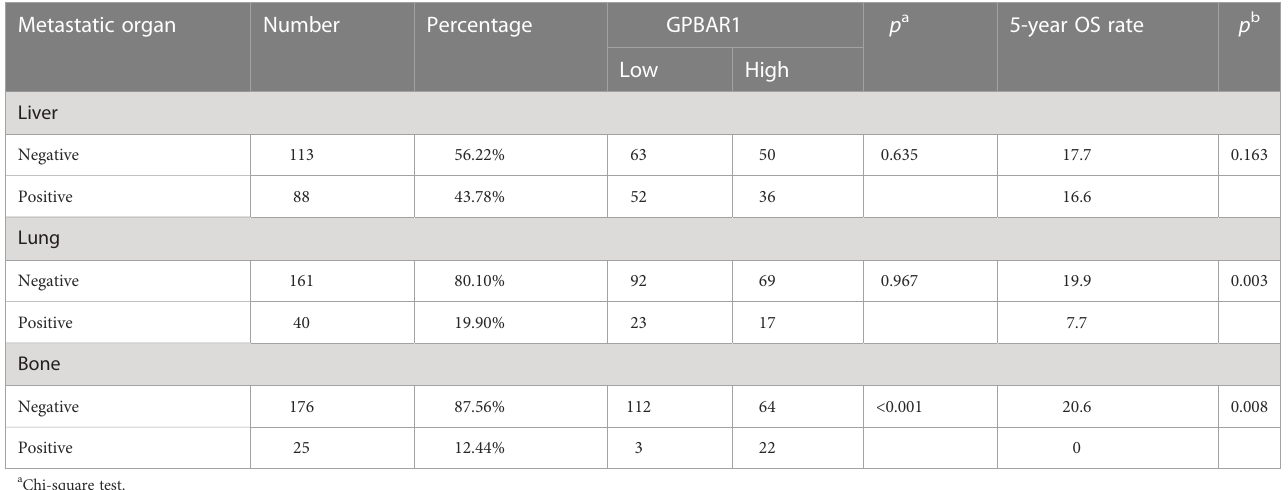
TABLE 3 Correlation between different metastasis, GPBAR1, and prognosis.